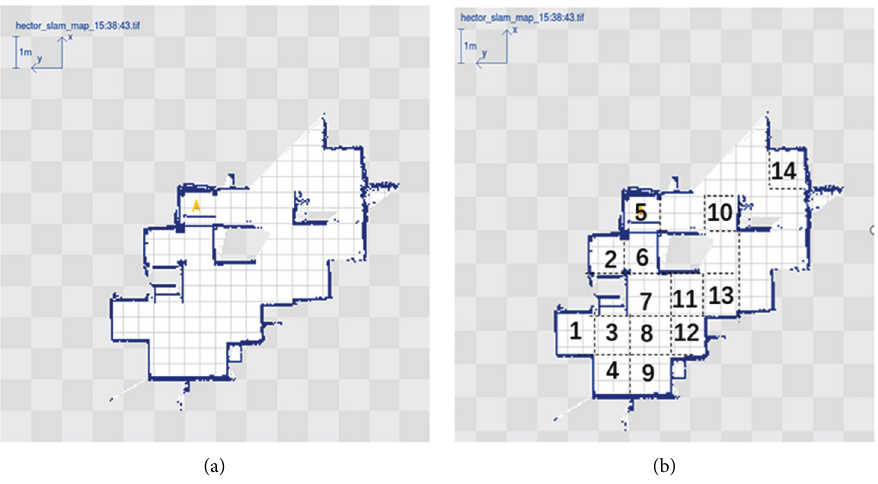
Figure 15: Mapping result of Hector-SLAM (RoboCup).